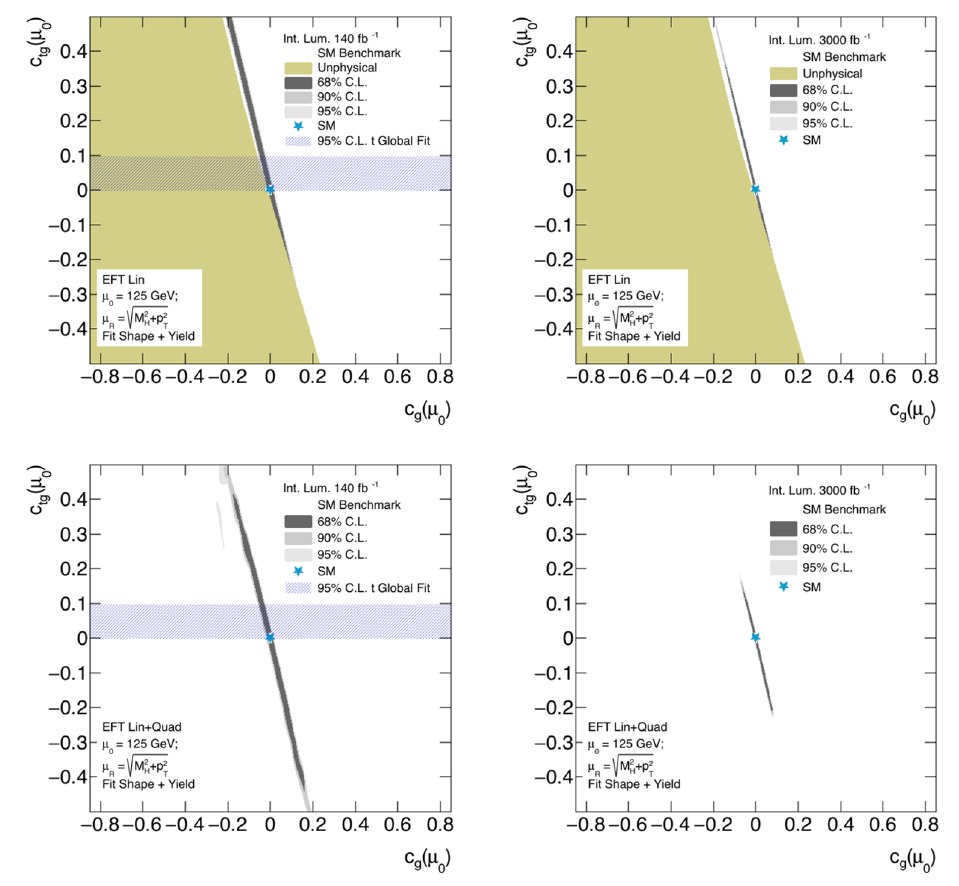
Figure 9. Constraints on the c g and c tg coefficients at 68% (dark grey), 90% (mid grey) and 95% (light grey) C.L. obtained from the fit to the spectrum shape and Higgs signal rate on 200 < p H 2000 GeV with 140 fb − 1 (left panels) and 3000 fb − 1 (right panels) for the linear (top panels) and with the addition of the quadratic terms (bottom panels). The SM value is indicated by the blue star and the best fit value by the white marker. The shaded horizontal strip indicates the 95% C.L. interval for c tg from the top quark fit of ref. [71] translated to our definition of c tg ( µ 0 ) . The region shown in colour and labelled “unphysical” in the fits with only SMEFT linear terms indicates the parameter space leading to negative unphysical values of cross section in the p H linear SMEFT approximation at dimension